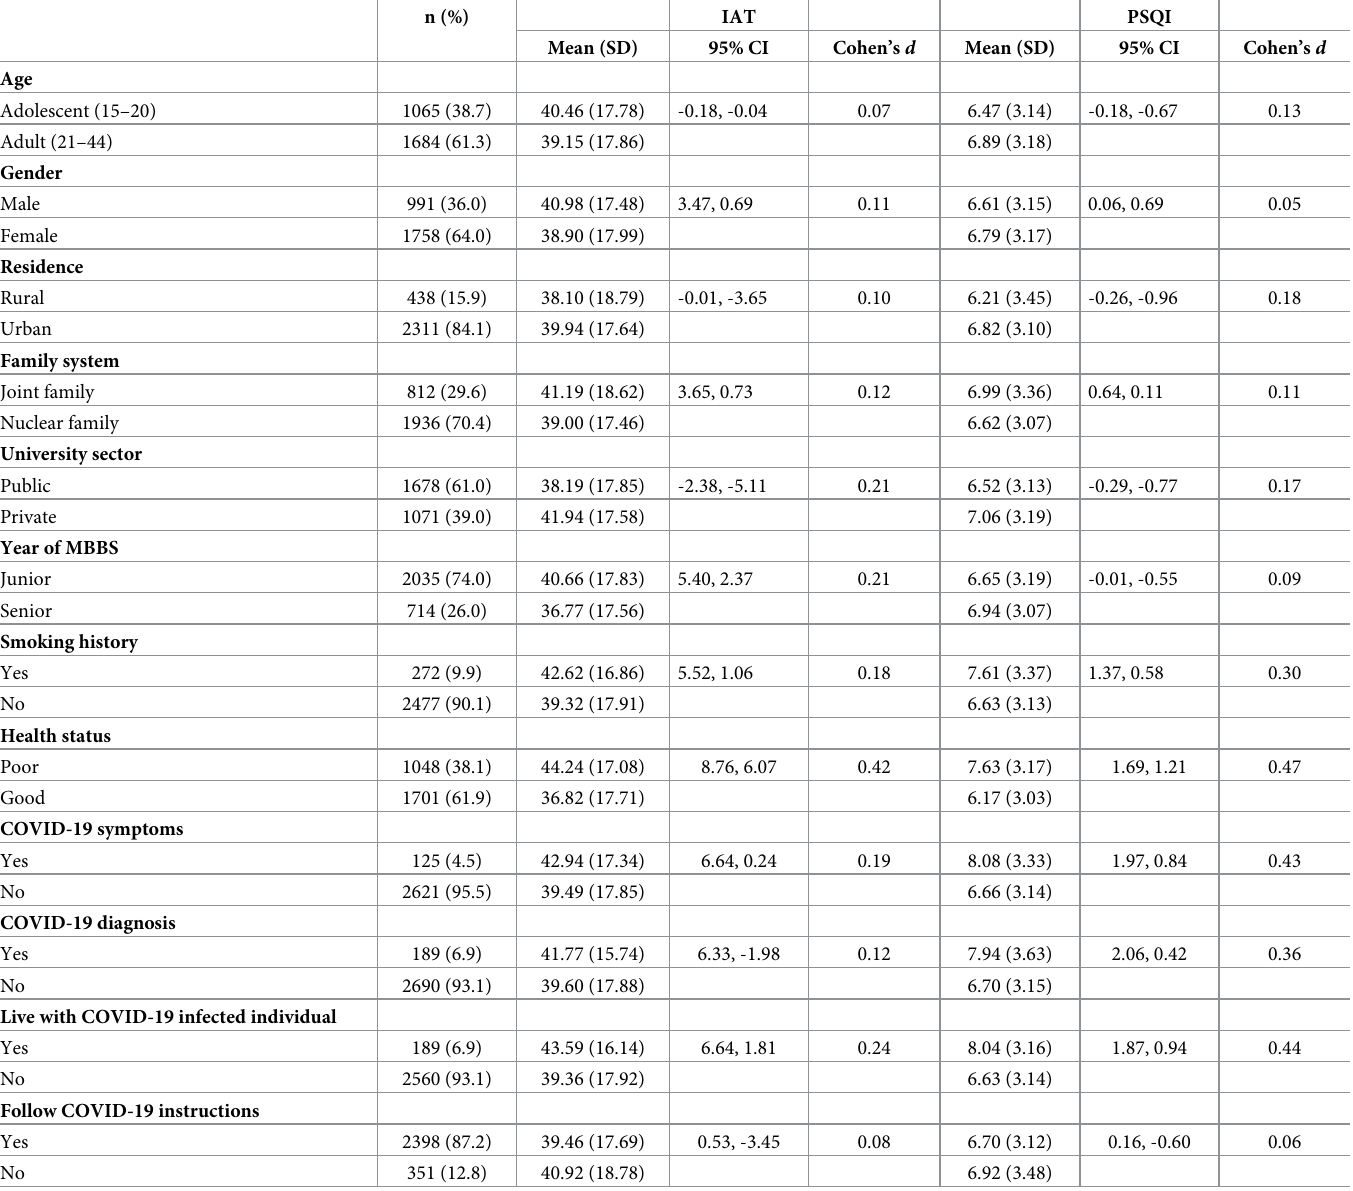
Table 1. Participants’ characteristics with comparisons of IAT and PSQI (N =